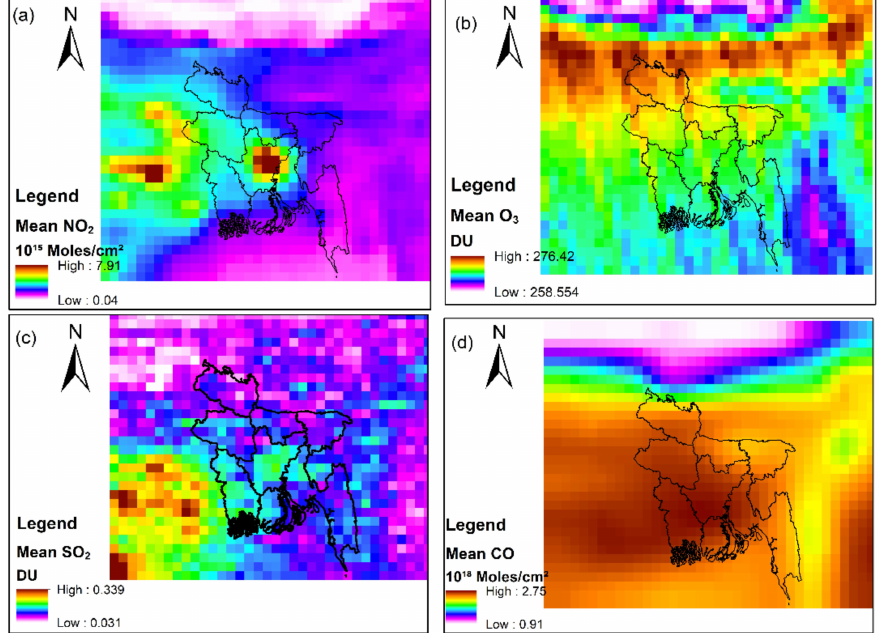
Figure 3. Mean values of air pollutants from 2015 to 2020 over Bangladesh and its surroundings: ( a ) NO 2 , ( b ) O 3, ( c ) SO 2 , and ( d ) CO. Dobson units (DU) indicate the column density, whereas µ g/m 3 , ppb (parts per